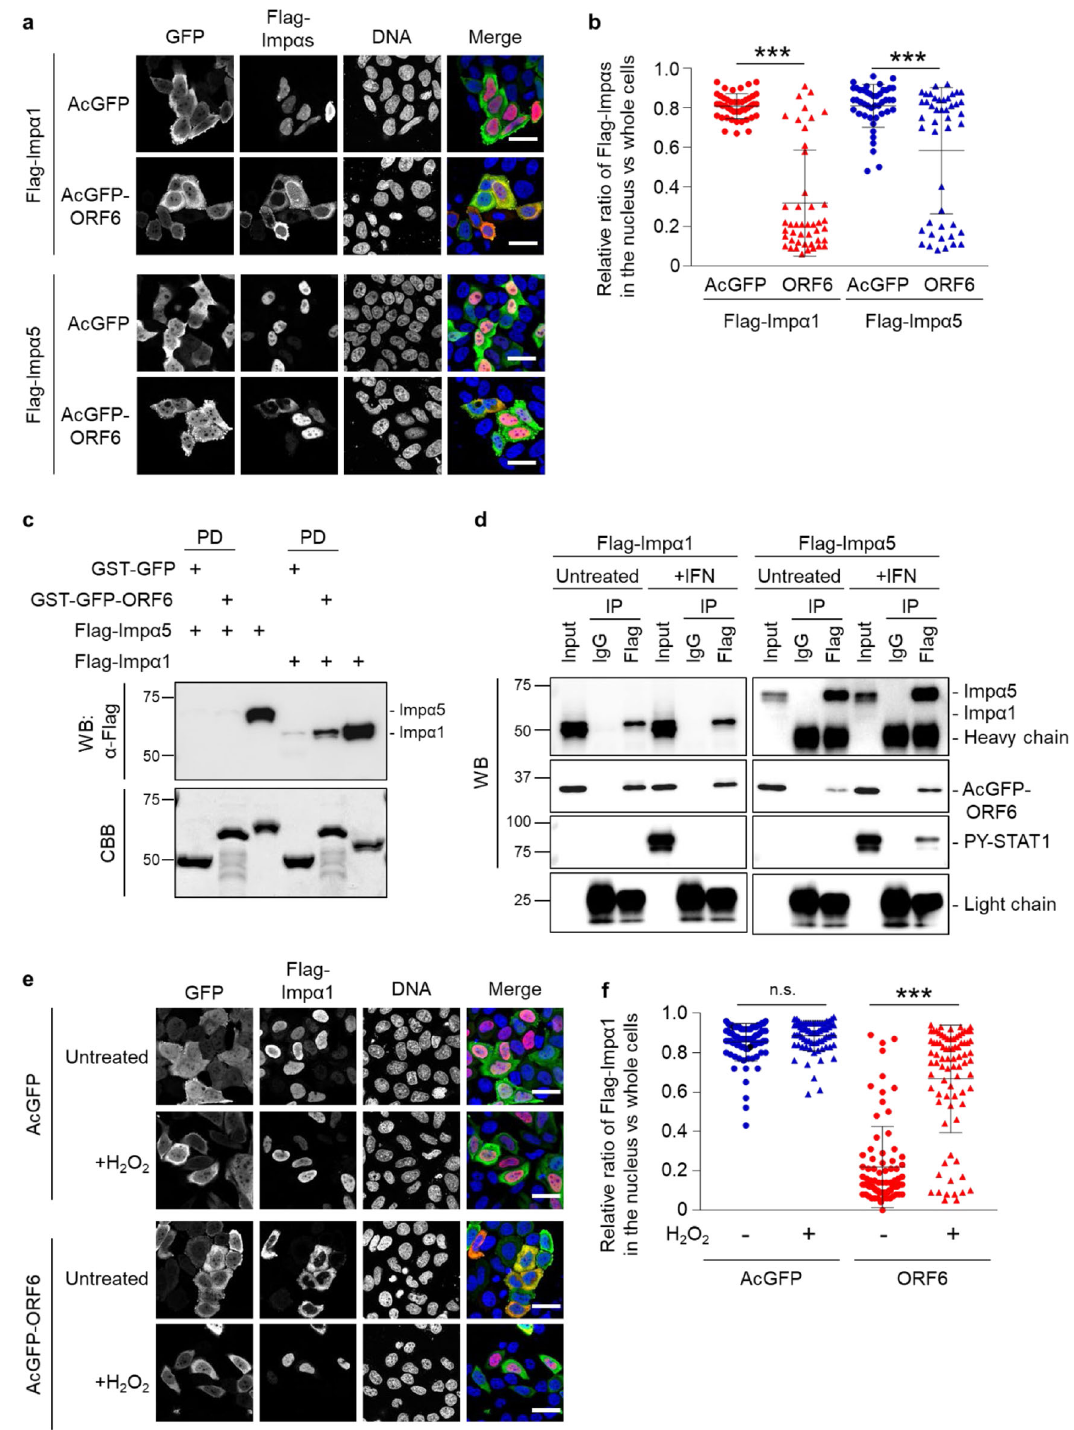
(Fig. 5a, b and Supplementary Fig. 3). In contrast, in AcGFP- ORF6-transfected cells, the localization of Flag-importin α 1, α 3, α 4, α 6, and α 8 remarkably shifted to the cytoplasm, while Flag- importin α 5 and α 7 were still mostly localized in the nucleus (Fig. 5a, b and Supplementary Fig. 3). The analysis of nuclear fl uorescence intensity ratios clearly shows that in AcGFP-ORF6- transfected cells, the nuclear distribution of Flag-importin α 1 was drastically shifted to the cytoplasm, while the number of cells in which Flag-importin α 5 is localized in the cytoplasm was